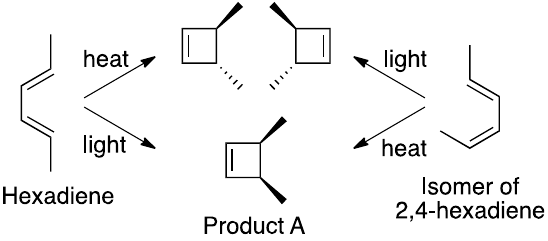
Figure 3. The set of products obtained by both 2,4-hexadiene and its isomer via heat- and light- induced processes.